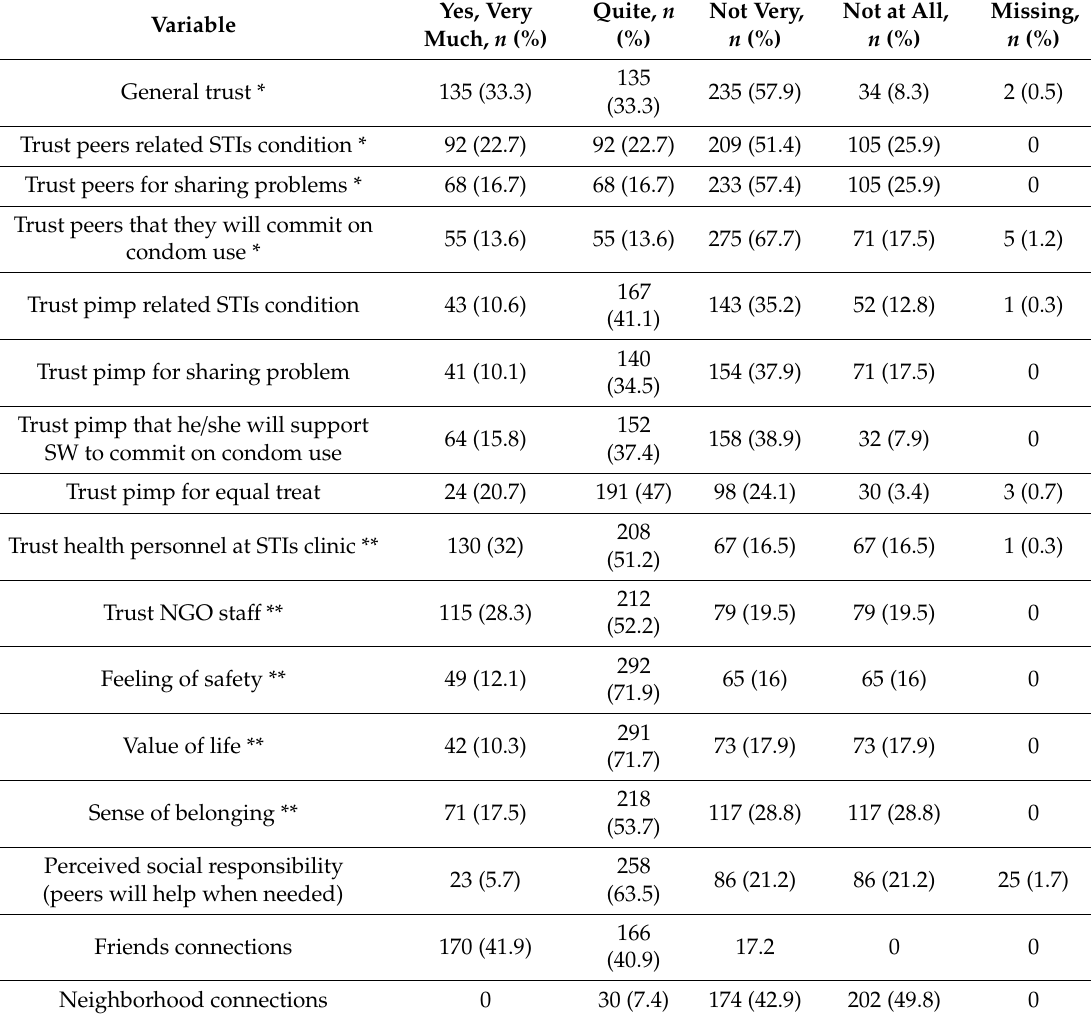
Table 3. Social capital dimensions, psychosocial factor, and consistent condom use of FSWs.